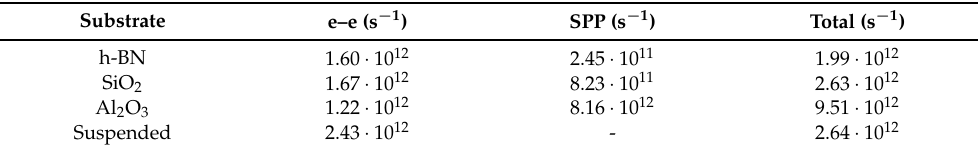
Table 2. Number of the most relevant scattering mechanisms per unit time, i.e., carrier–carrier (e–e) interaction and SPP, suffered by the carriers on the different samples under study at E AC = 0.5 kV/cm. In addition, the total scattering events are reported.